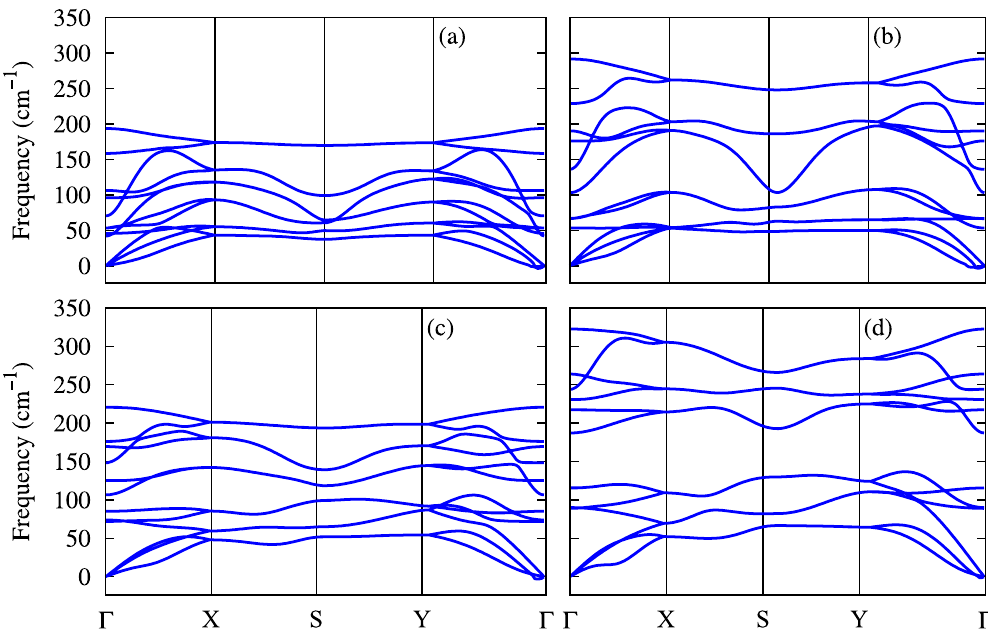
Figure 5. Phonon dispersions along high symmetry k -points for ( a ) SnSe, ( b ) SnS, ( c ) GeSe, and ( d )